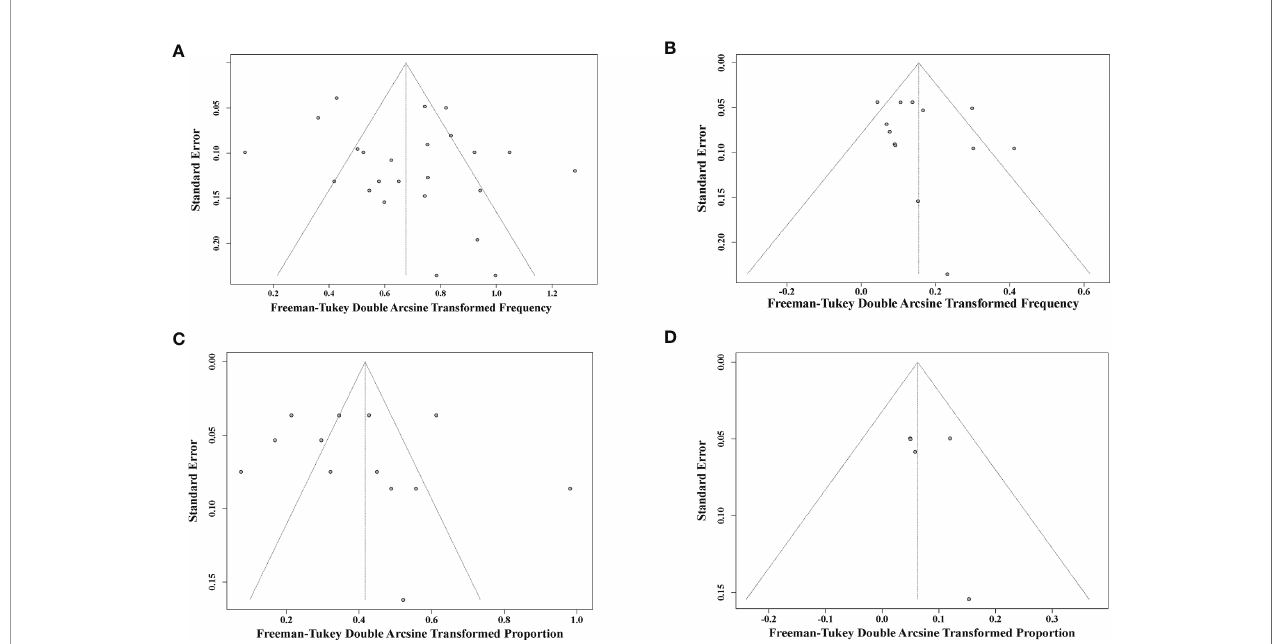
FIGURE 5 | Funnel plot shows publication bias of the identi fi ed surveys for early-cART children (A) , deferred-cART children (B) , early-cART adults (C) , and deferred- cART adults (D) . cART, combination antiretroviral therapy.